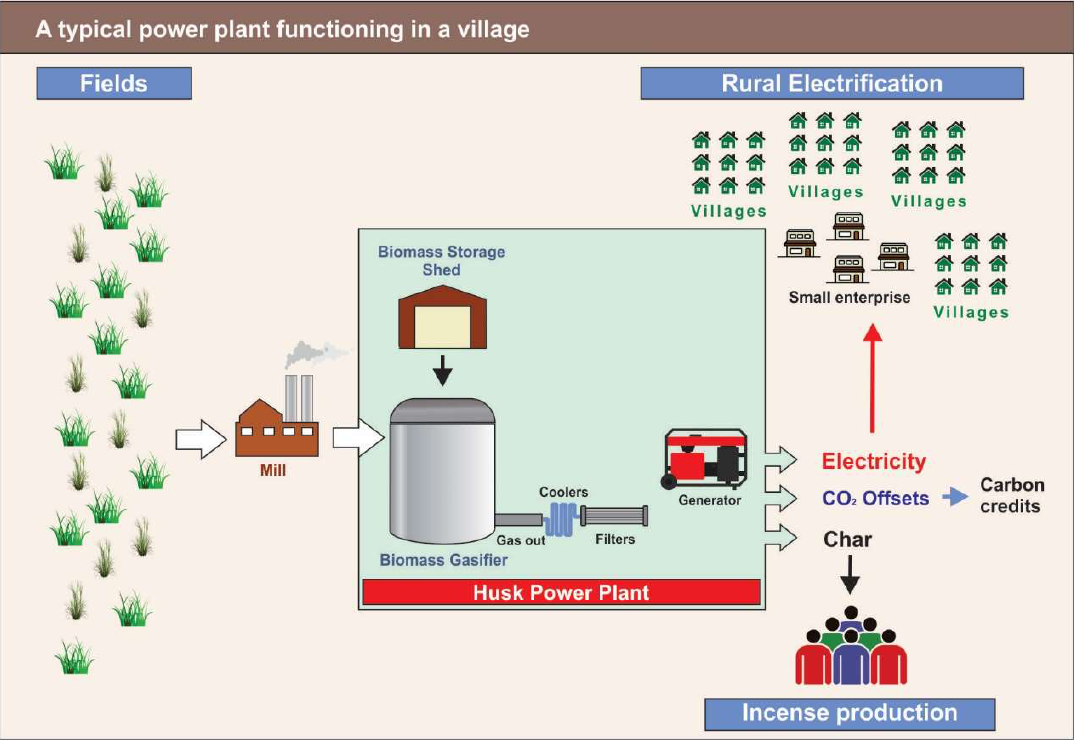
Figure 3. A typical rice husk power plant. 202